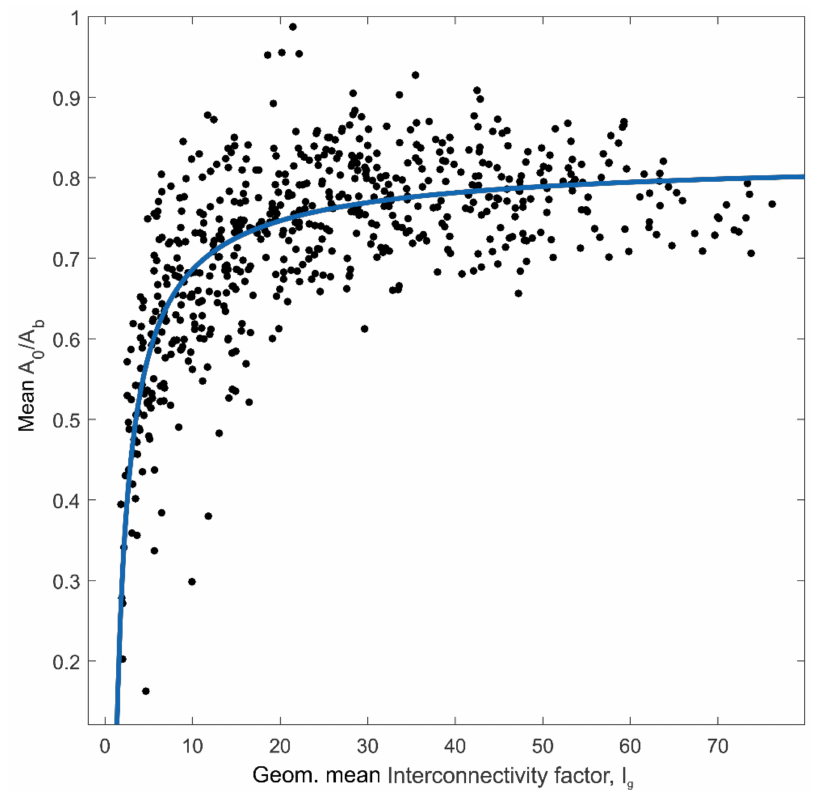
Figure 5. Correlation between the geometric mean interconnectivity factor ( I g ) and the mean A 0 / A b ratio based on about 600 simulations with different input values for fracture frequency, orientation, and trace length (blue line: power law curve